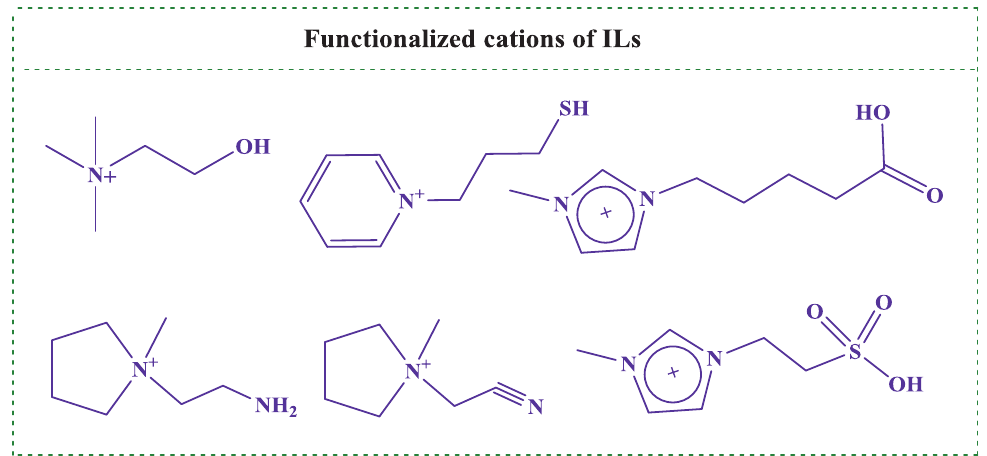
Scheme 2. Functionalized cations of